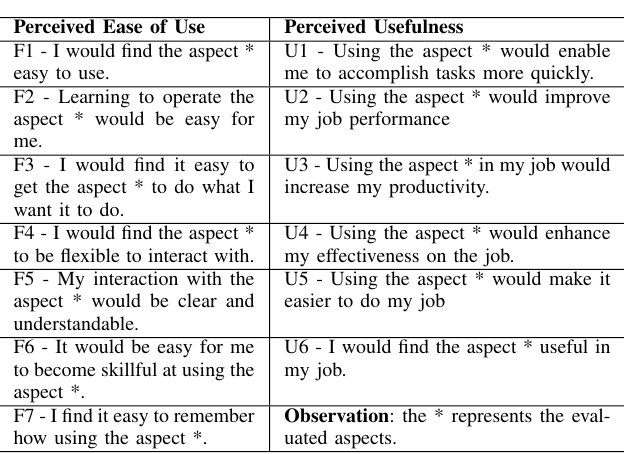
pre-questionnaire ; and Tasks execution (see Table